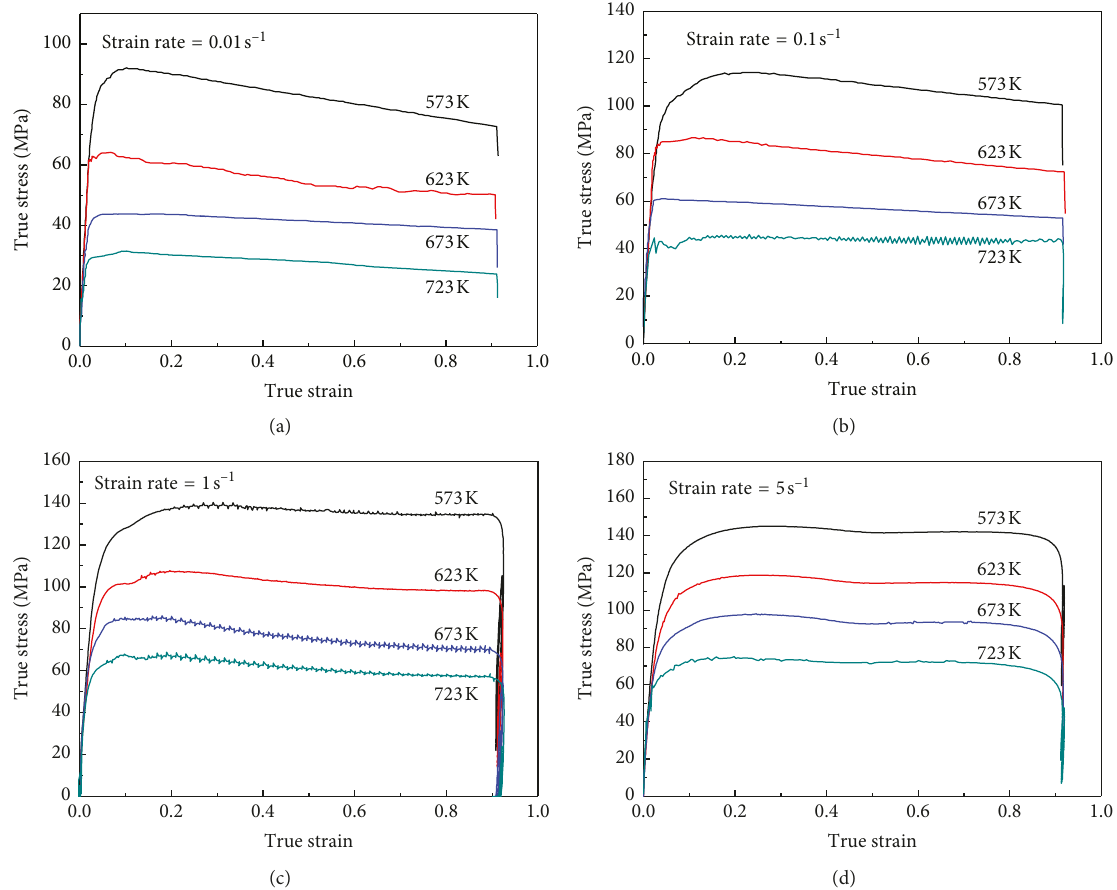
Figure 1: True stress-strain curves of the AA6061 under PSC with strain rates of (a) 0.01s − 1 ; (b) 0.1 s − 1 ; (c) 1s − 1 ; and (d) 5s − 1